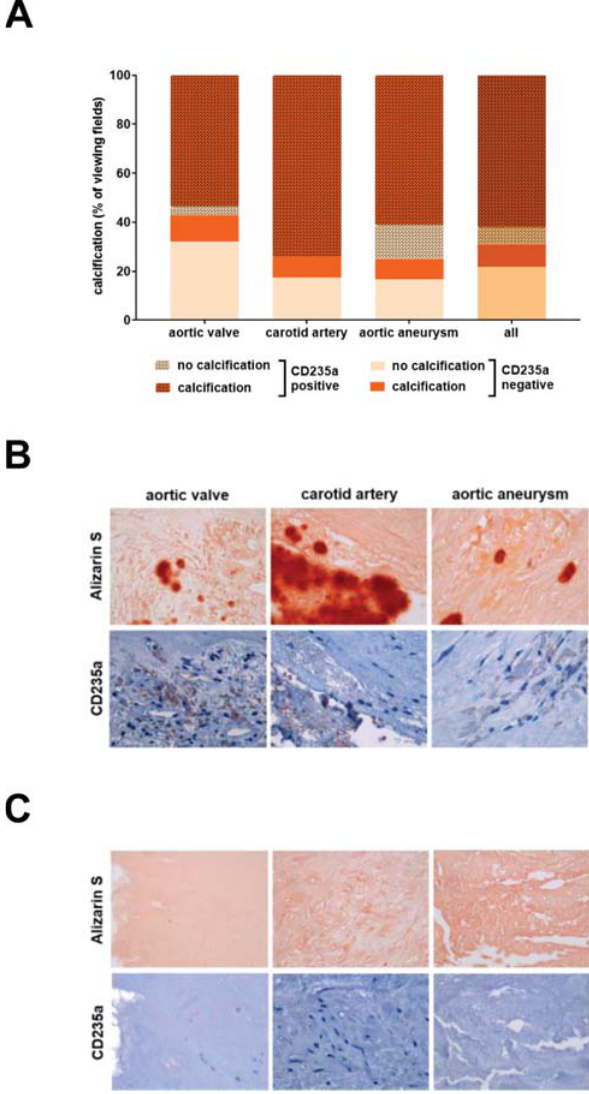
Fig. 3 Colocalization of erythrocyte membrane markers and areas with or without calci fi cation in human vascular lesions. ( A ) Results of the quantitative analysis. Results are expressed as percentage (%) of the total number of viewing fi elds. Representative fi ndings showing examples for the colocalization of CD235a and Alizarin red S ( B ) or the absence of calci fi cation in areas not containing erythrocyte mem- branes in samples of human aortic valve stenosis, carotid artery plaque and aortic aneurysm ( C ); 1,000-fold magni fi